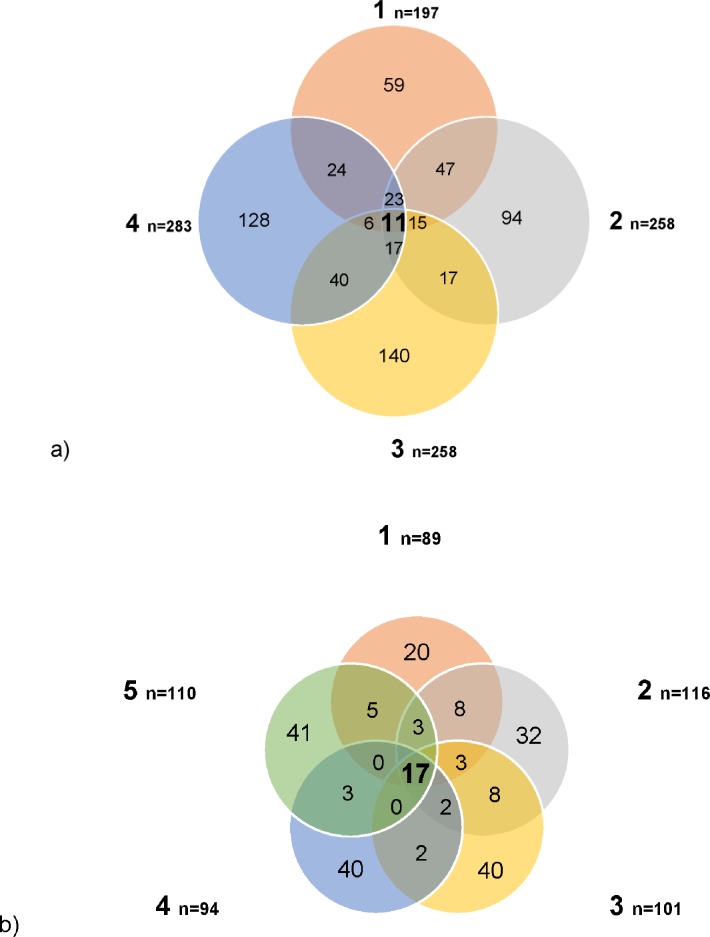
Venn diagrams showing distribution of bacterial OTUs between (a) P. endroedyi and (b) P. striatum individuals based on the 16S rRNA gene pyrosequencing analysis. Shared OTUs are shown in bold. Numerical labels are shown for each individual.